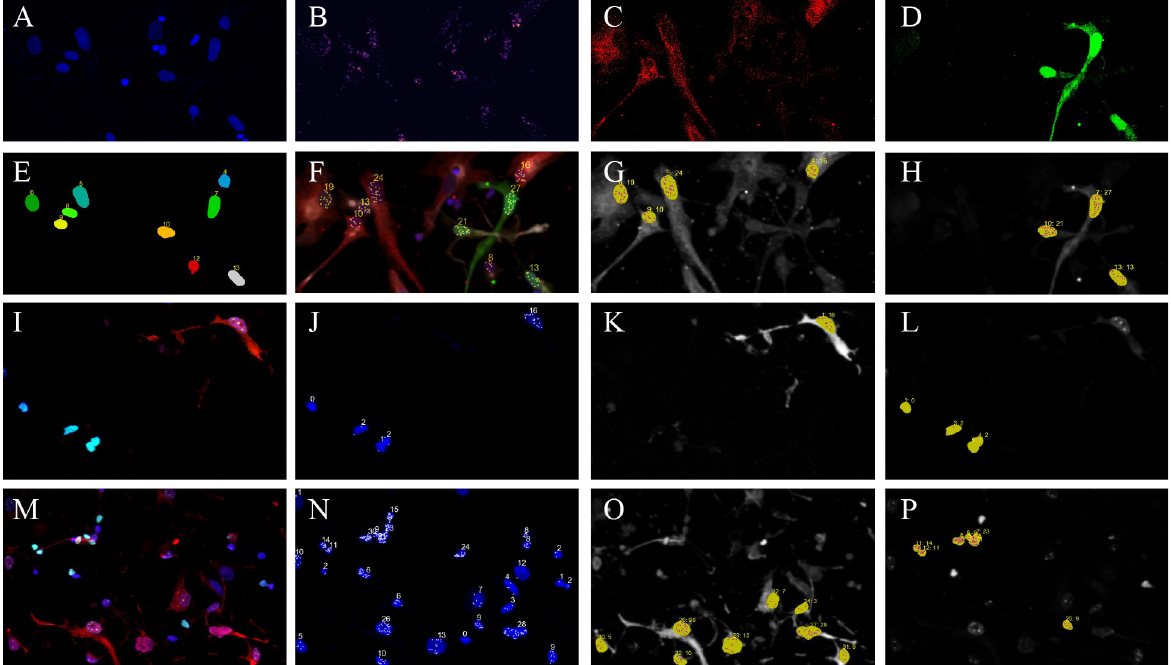
Fig 4. Integrative analysis of cell type-specific transcirpt counts by SMART-Q. (A, C, D) Immunocytochemistry staining for nuclear, GFP and mCherry. (B) RNAscope targeting HES1 transcripts in radial glia cells. (E) Nuclear segmentation. (F) Pseudocolor composition of all channels, including cell type-specific transcript counting. (G, H) Transcript counts in GFP/mCherry positive cells. (I, M) Composite image of immunocytochemistry staining in primary cells. Radial glia cells are labeld with GFAP (red), and excitatory neurons are labeled with SATB2 (green). (J,N) Nascent RNA transcript counts in all nuclei. (K, O) Nascent RNA transcript counts in identified radial glia cells. (L, P) Nascent RNA counts in identified excitatory neurons. (I-L) RNAscope with probes targeting intronic region of HES1 . (M-P) RNAscope with probes targeting intronic regions of BCL11A . The scale bars are 30 μ